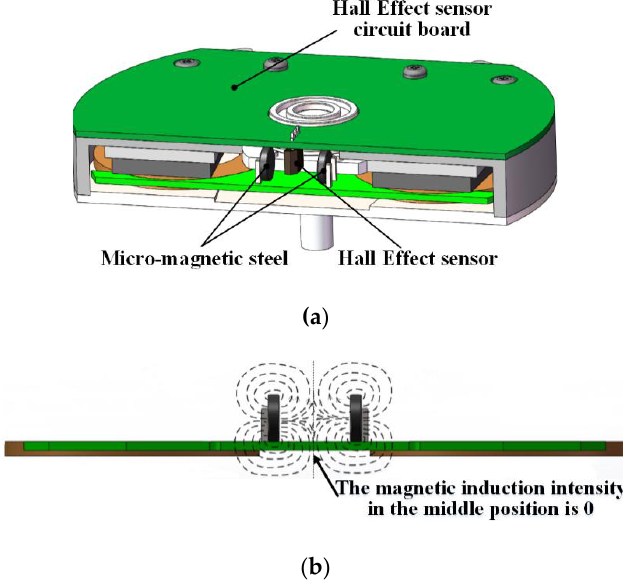
Figure 6. The composition of the ultralight VCM. ( a ) VCM and Hall e ff ect sensor sectional view; ( b ) micro-magnetic steel working